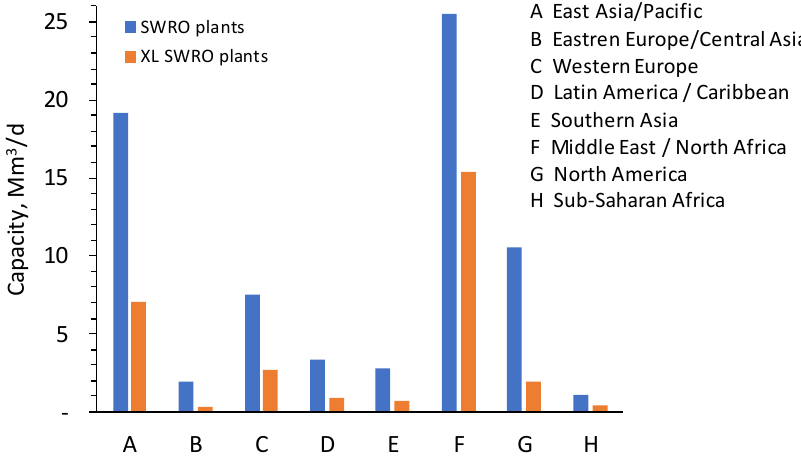
Figure 2. Classification of SWRO desalination plants based on their capacity [3].